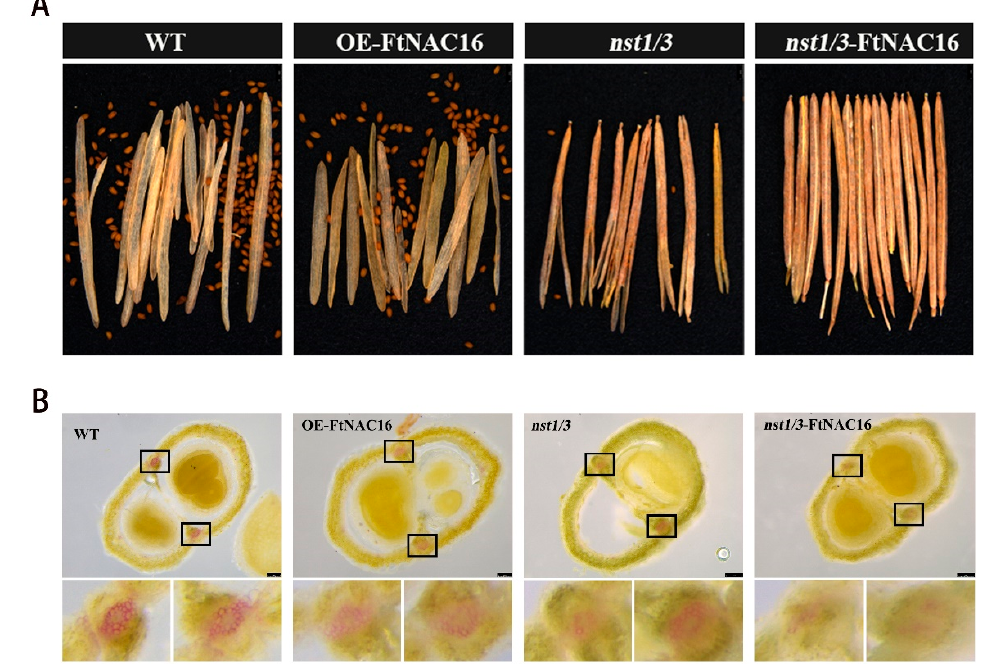
Figure 2. Dehiscence of four genotypes of A. thaliana and lignin deposition patterns in the cracking area. ( A ) Phenotypic map of mature fruit pods of wild-type (WT), OE-FtNAC16, nst1/3 and nst1/3 -FtNAC16; ( B ) A. thaliana fruit pods were cross-cut, lignin was stained with phloroglucinol, and the cracking area of the black box was locally enlarged.